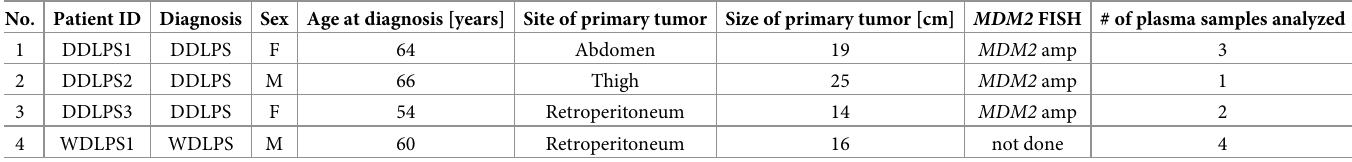
Table 1. Summary of clinical features of DDLPS and WDLPS